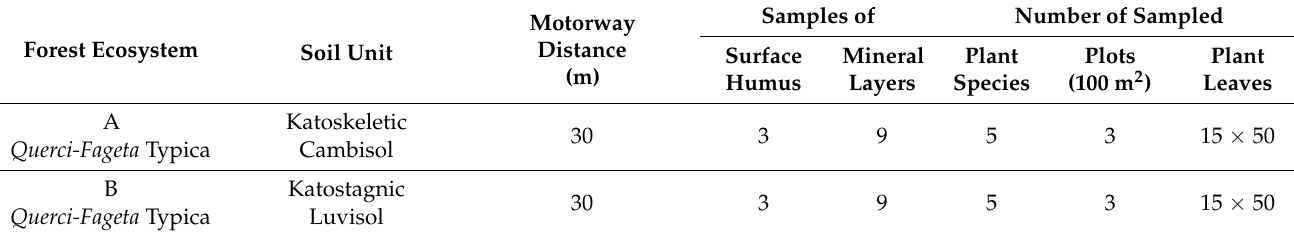
Table 2. Experiment